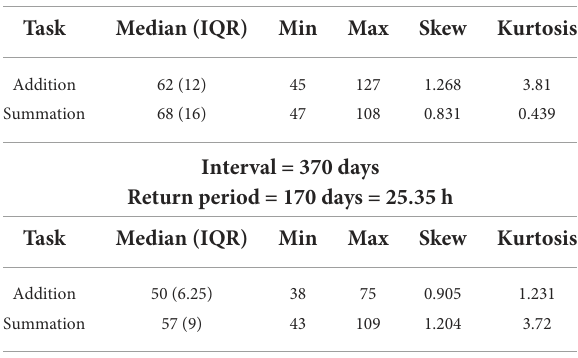
TABLE 1 Response time for addition and summation tasks for the initial and return study periods.